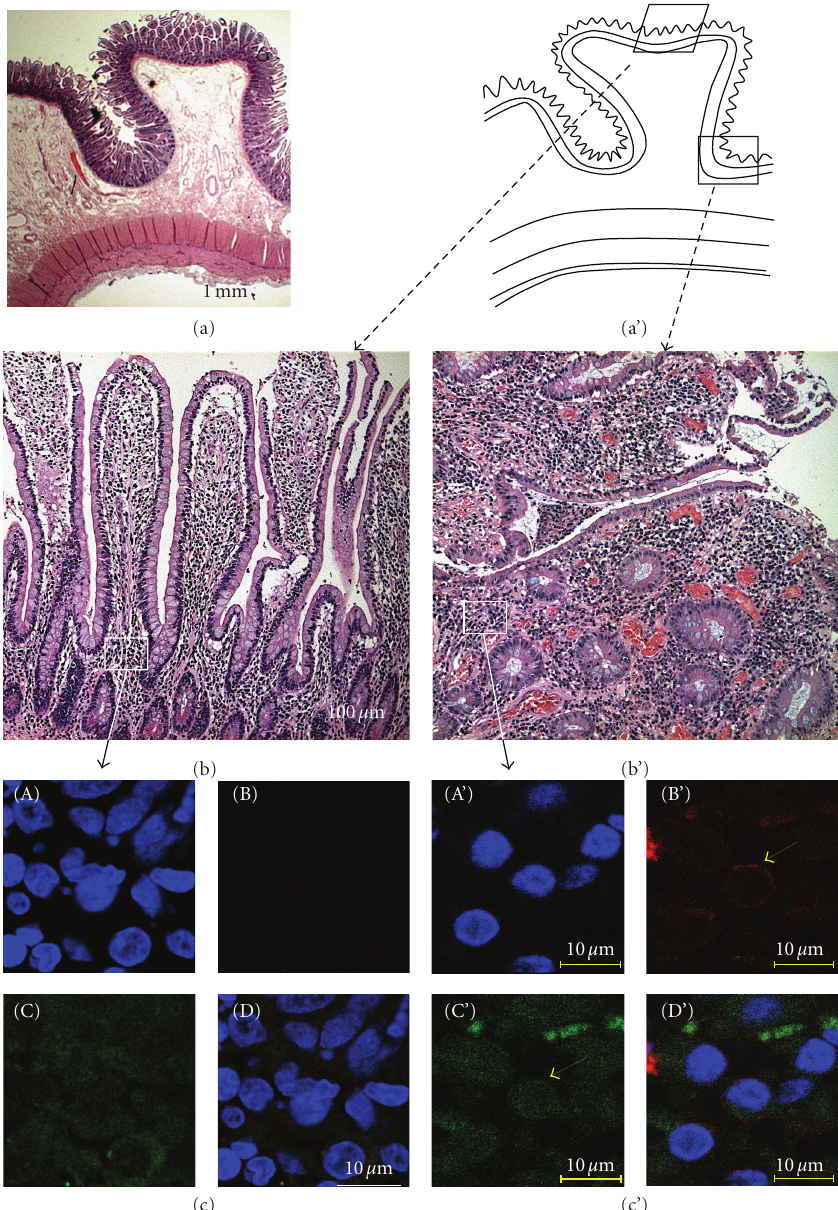
Figure 3: CCR7 presence in the lamina propria of inflamed tissues of CD patients (c’) compared to the healthy donor (c) by confocal microscopy. (a) Hematoxylin/eosin coloration of healthy intestine showing the localization of the di ff erent magnifications. (b and b’) Magnification of the Lieberkuhn’s glands to show localization of the chorion: (b) non-inflamed tissue, (b’) inflamed part. (c and c’) CCR7 is detected in the inflamed CD tissues by confocal microscopy revealed by an Alexa 647 labeled secondary antibody: (c) non-inflamed lamina propria , (c’) inflamed lamina propria . CCR7 staining (B and B’), nucleus staining with DAPI (A and A’), green autofluorescence (C and C’) and corresponding merged images (D and